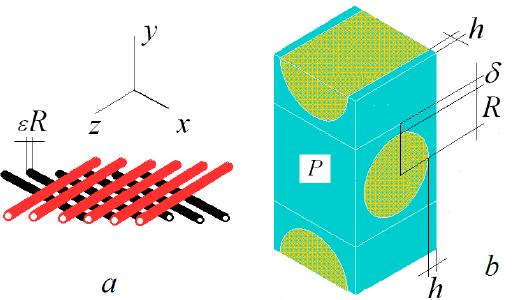
Figure 1. Layers of fibers in “slow” variables x and PC P of composite in the “fast” variables y .